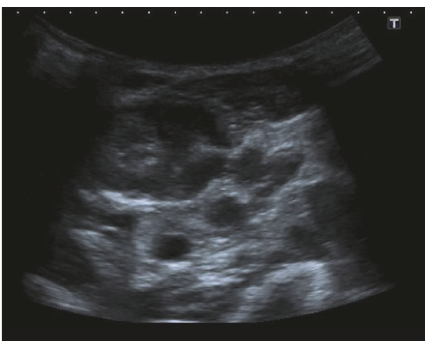
Figure 4: Ultrasound scan showing an enlarged left cervical lymph node with heterogeneous